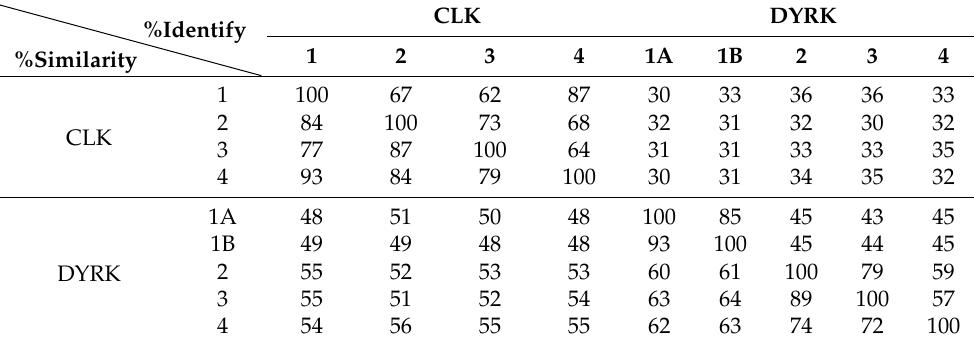
//blast-ncbi-nlm-nih-gov.cov) (accessed on 1 June 2021).